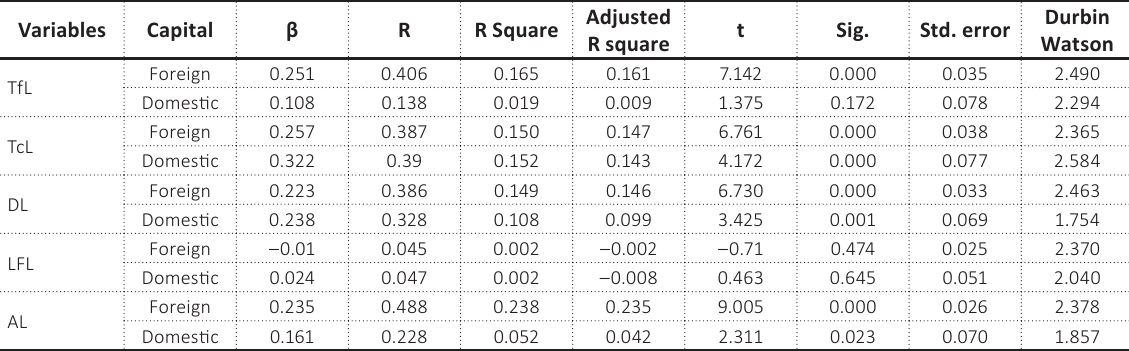
Table 5. OLS model according to the categorization of banks for leadership styles and service quality Variables